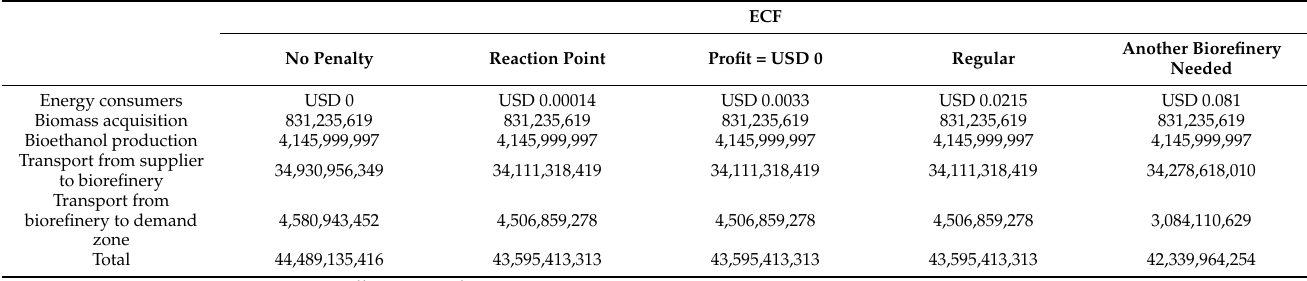
Table 9. Energy consumers reaction to different ECFs values at 300 MGPY demand level